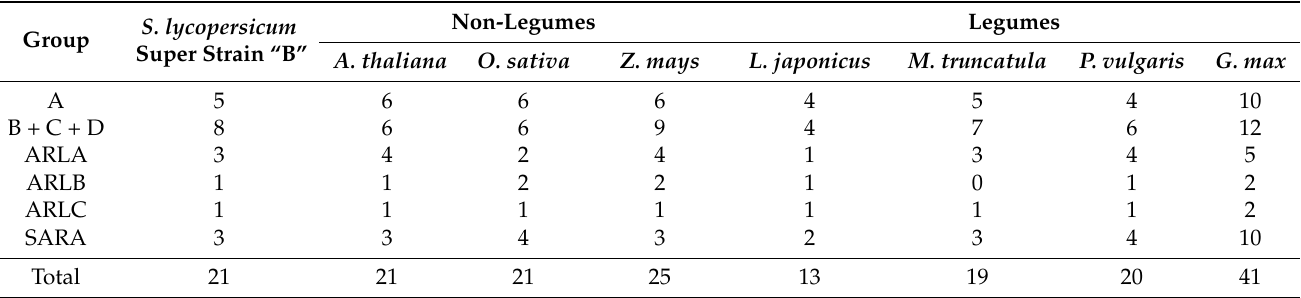
Table 3. Number of small GTPases Arf subfamily members expressed in Solanum lycopersicum super strain “B” compared with some non-leguminous and leguminous plants retrieved from the data